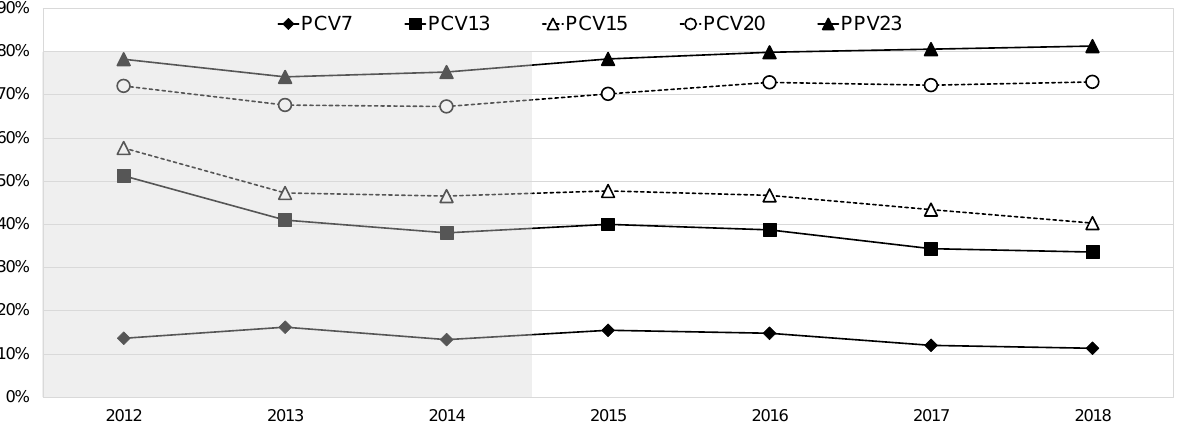
Figure 4. Proportion of isolates expressing serotypes included in existing and future pneumococcal vaccines causing invasive pneumococcal disease in adult patients ( ≥ 18 years) in Portugal from 2012 to 2018. The data up to 2014 were presented previously [1]. See text for the serotypes included in each of the vaccines.